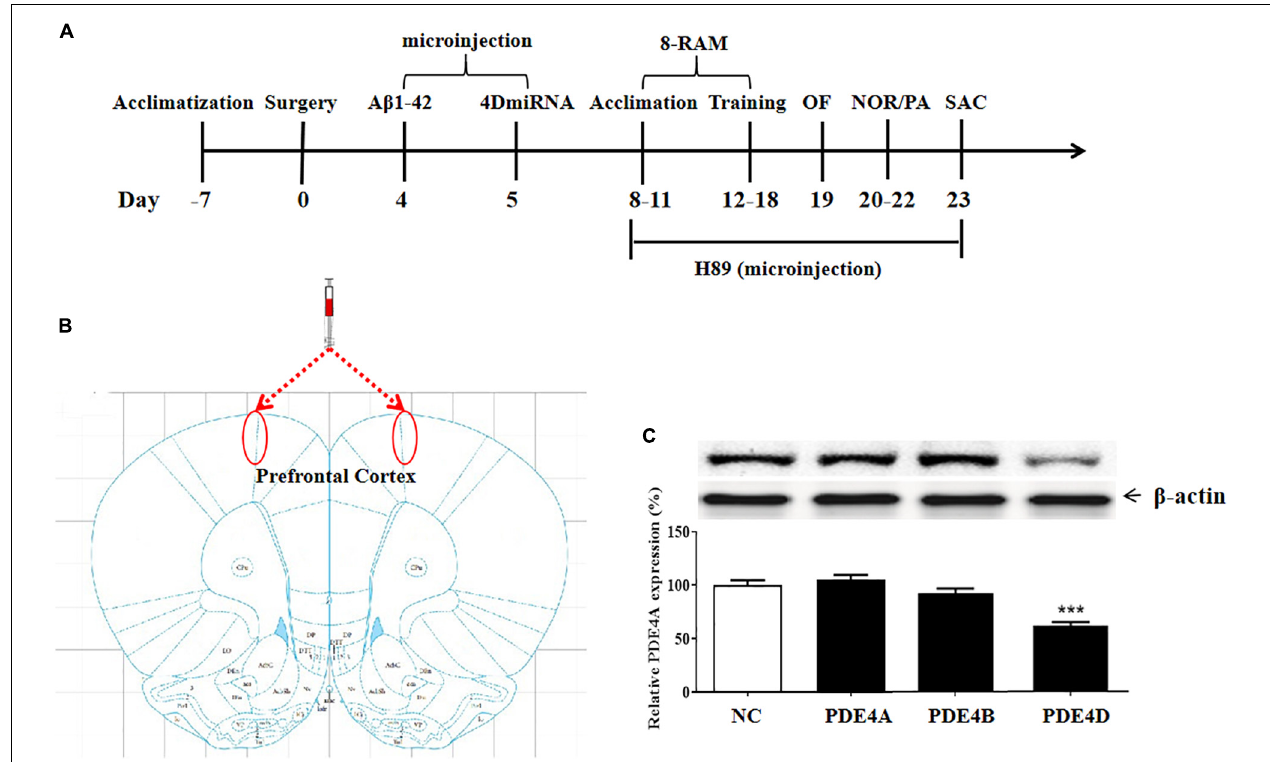
FIGURE 1 | (A) Experimental design and the test order. A β 42 was microinfused into bilateral prefrontal cortices of mice on day 4 after surgery. Lentiviral vectors containing negative control sequence (NC) or 4DmiRNA were microinfused into bilateral prefrontal cortices of mice on day 5 after surgery. H89 or artificial cerebrospinal fluid were microinjected once daily starting from days 8 to 22. Behavioral experiments were performed from days 19 to 22, 30 min after H89 treatment. Animals were sacrificed for biochemical assays after behavioral tests (day 23). OF, open field test; NOR, novel object recognition test; PA, passive avoidance test; 8-RAM, eight-arm radial maze; SAC, sacrifice. (B) Photomicrographs of representative cannula placements in the brain region of microinjection are indicated by the red ellipse corresponding to the region. (C) PDE4 subtypes expression in the prefrontal cortex. PDE4D expression, but not PDE4A and PDE4B, was decreased after microinjection of lenti-PDE4D-miRNA into the prefrontal cortex for 2 weeks. Values were the means ± SEM with 12 mice in each group. *** P < 0.001 vs. vehicle-treated control group